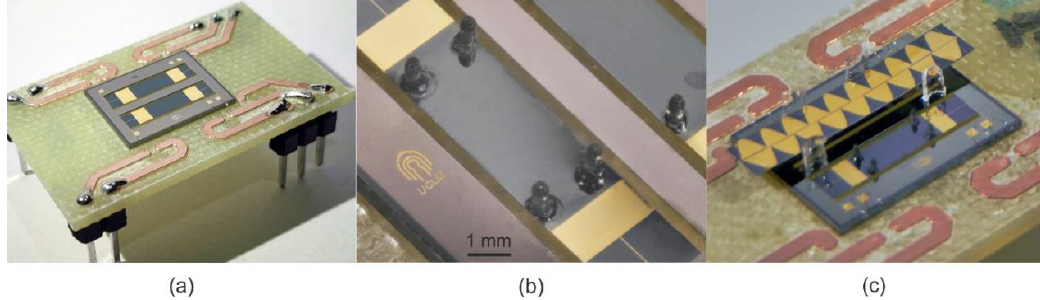
Figure 5. Photographs of the fabricated devices. ( a ) Silicon dice containing two HF designs, wire bonded to a printed circuit board (PCB), ( b ) detail of the legs attached and ( c ) the experimental setup, with a gold-patterned slider on top of a legged TW motor, and constrained to a lane by four glass pieces.